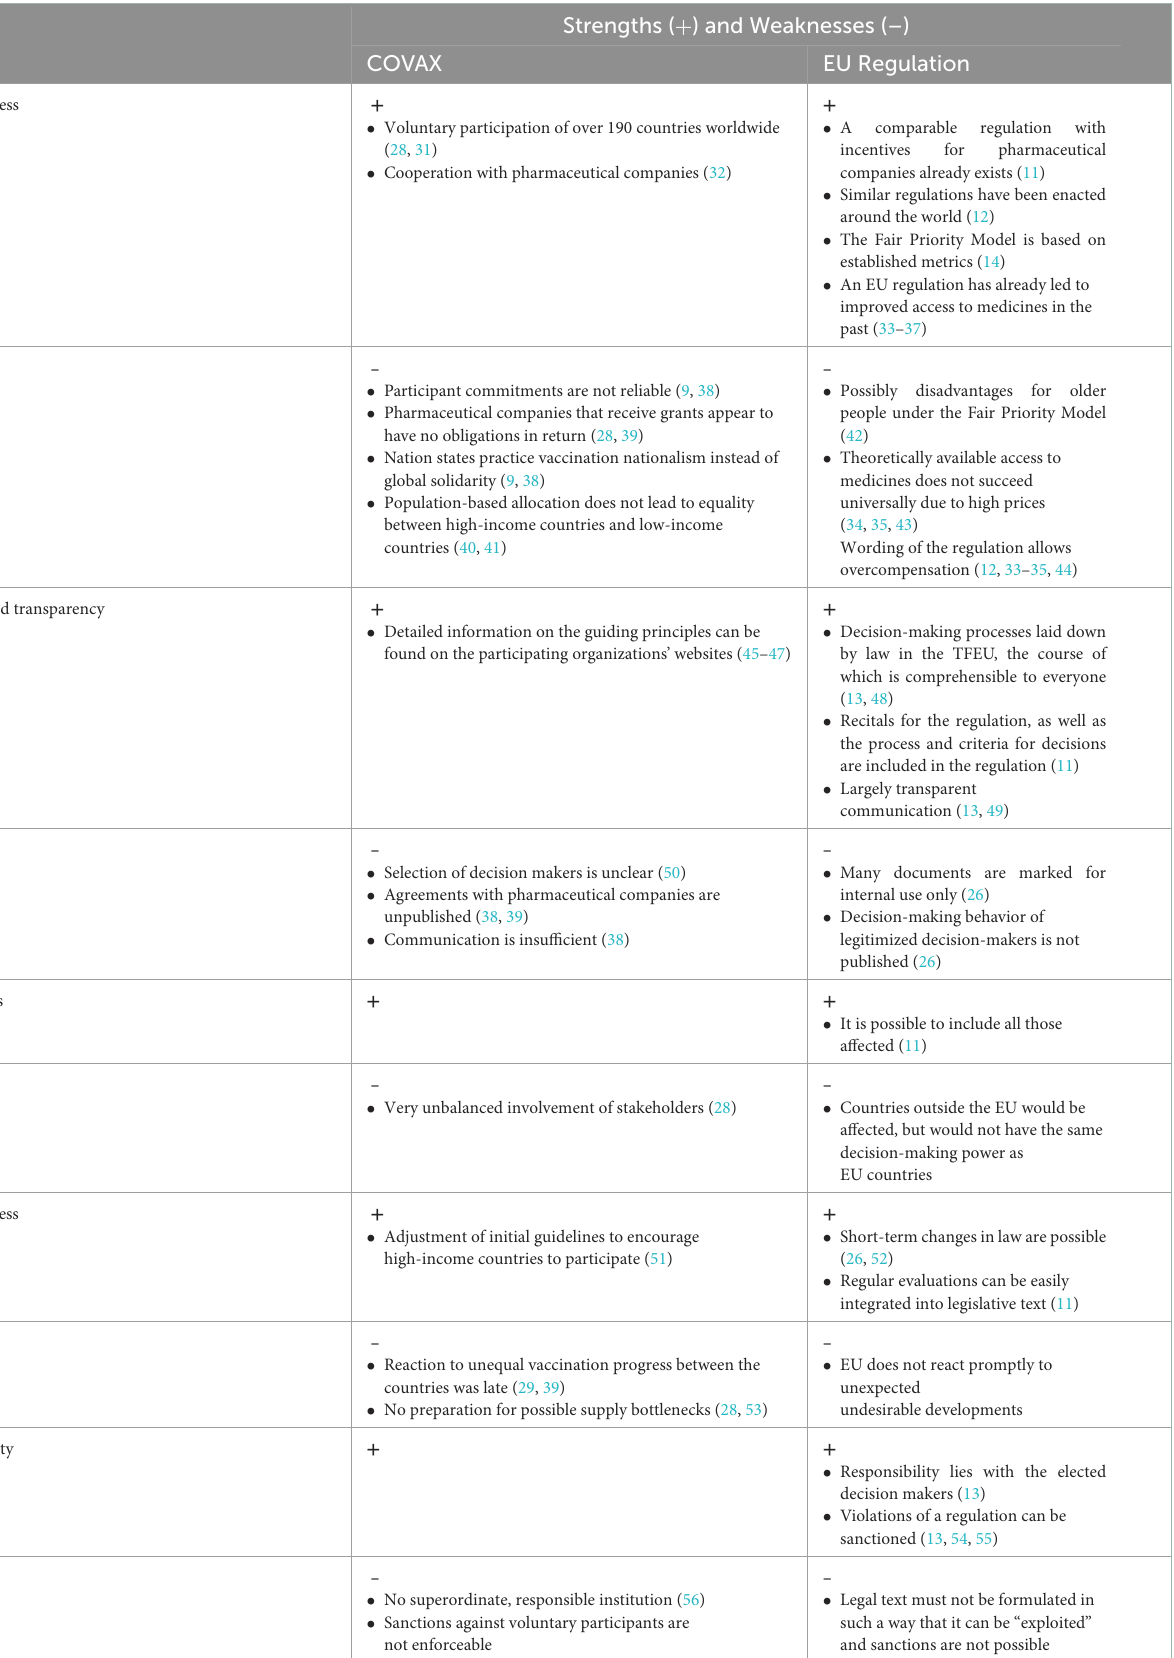
TABLE 2 Summary strengths and weaknesses of the decision-making process at COVAX and a legislative